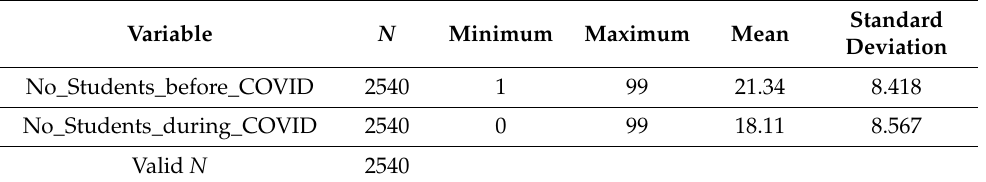
Table 18. Descriptive statistics of the number of students attending classes before and during COVID-19.